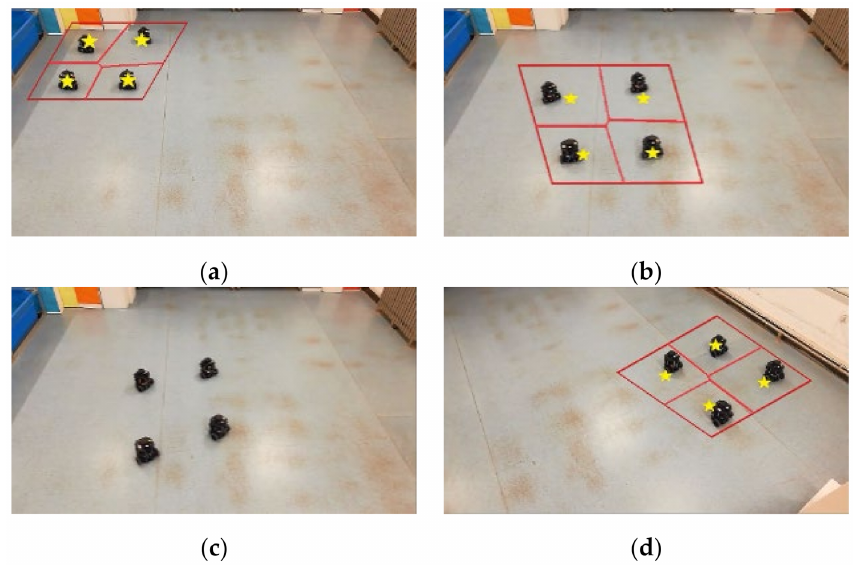
Figure 21. Multi-robot dynamic formation experiment in the obstacle-free scene: ( a ) t 1 = 0 s; ( b ) t 2 = 64 s; ( c ) t 3 = 75 s; ( d ) t 4 = 120